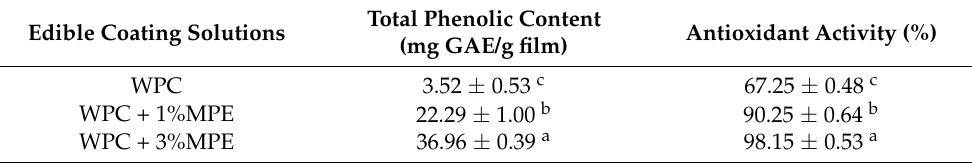
Table 1. Total phenolic content and antioxidant activity of used edible coatings (WPC = whey protein concentrate alone, WPC + 1% MPE= whey protein concentrate + mango peel extract at 1% and WPC + 3% MPE = whey protein whey protein concentrate + mango peel extract at 3%). Edible Coating Solutions